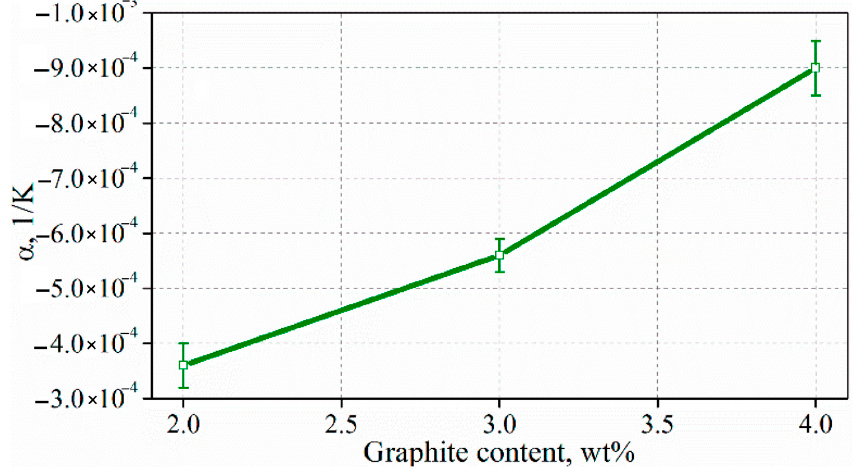
Figure 12. Temperature coefficient of resistivity for cement composites with exfoliated graphite.